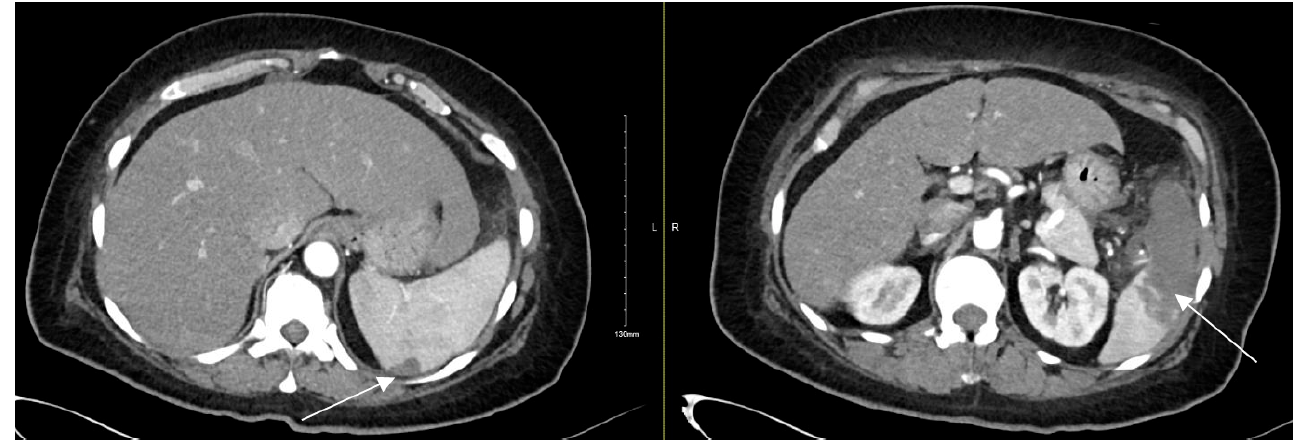
Figure 6. Abdominal and pelvis CT showing a large hypodense area in the lower pole of the spleen with and another upper pole linear hypodensity, representing infected splenic infarction. The white arrows point at hypodense areas indicating splenic infarction.